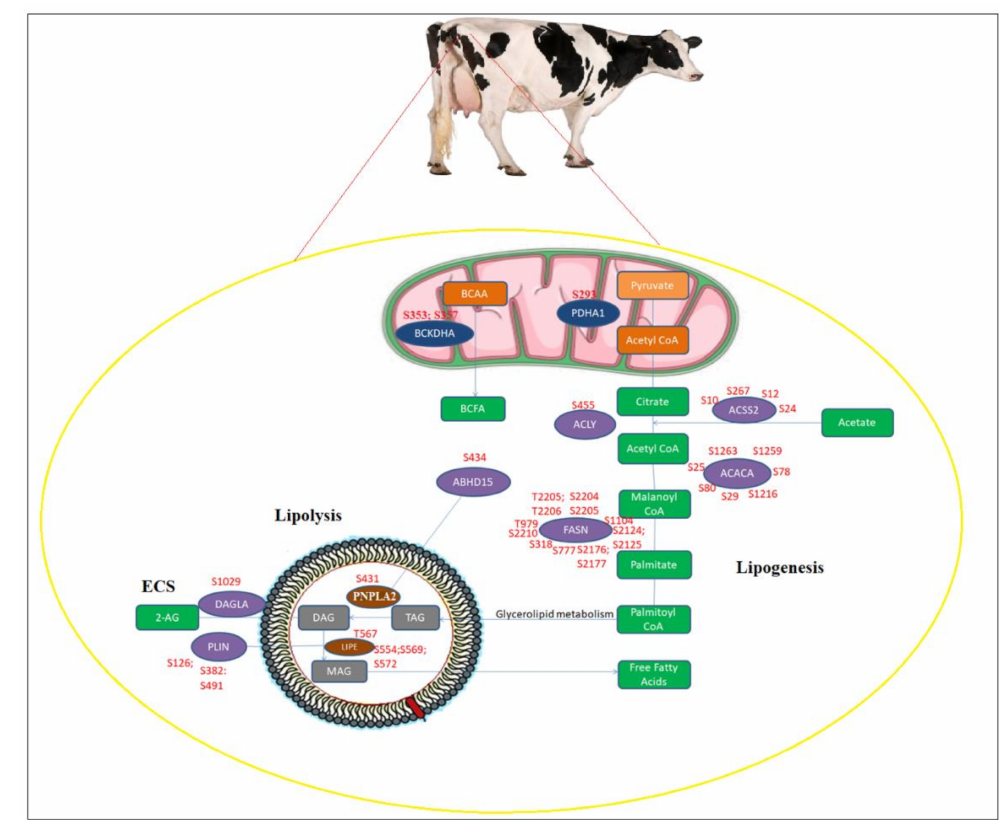
Figure 6. Altered phosphorylation of lipid metabolic pathways including lipogenesis and lipolysis in SC and OM AT of dairy cows supplemented with CLA. Enzymes with increased or decreased phosphorylation upon CLA supplementation were mapped to lipid metabolism networks. Additionally, the endocannabinoid system (ECS) mechanism was linked to lipolysis based on the literature. Enzymes and metabolites were represented in circles and rectangles respectively. Altered enzymes in cytoplasm shown (purple), in mitochondria (dark blue); and in lipid droplets (brown); metabolites of lipogenesis in mitochondria (orange) and in cytoplasm (green); metabolites of lipolysis in lipid droplets (grey